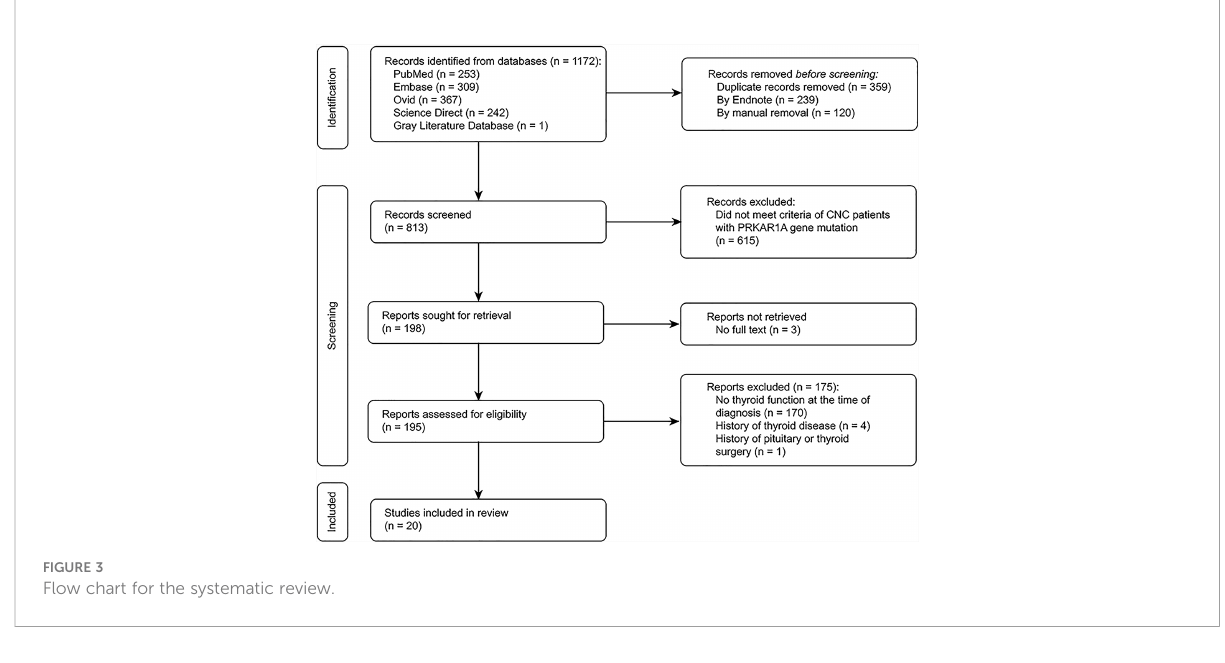
TABLE 2 Characteristics of the included studies.